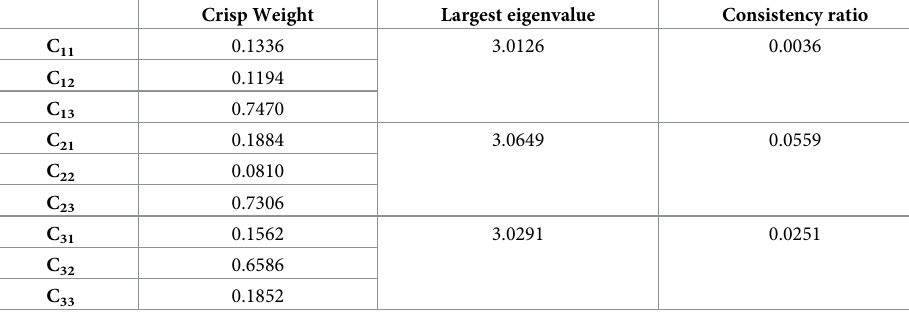
Table 9. Values of the weights, largest eigenvalue and consistency